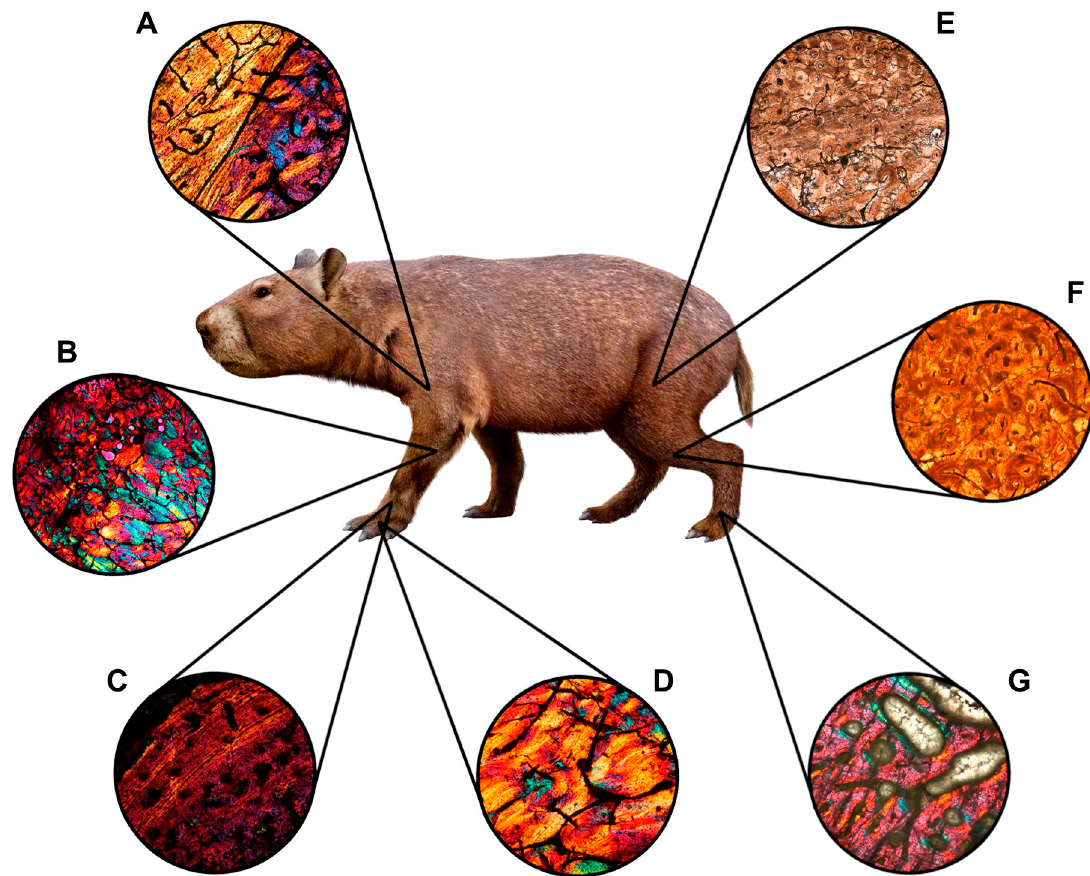
Fig 13. Reconstruction in life of Caraguatypotherium munozi from the middle Miocene of Caragua, Huaylas formation and histological detail. (A) Humerus; (B) Ulna; (C) Metacarpal III; (D) 1 st Phalange; (E) Femur; (F)Tibia; (G) Metatarsal II. (Illustration made by Carlos Andre´s Espinosa